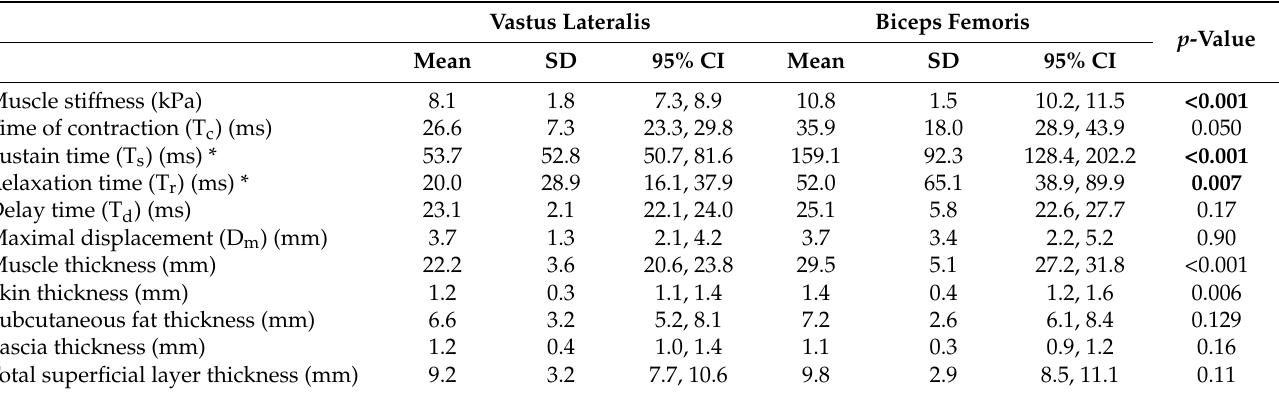
Table 1. Mean and 95% confidence interval for the ultrasound and tensiomyography variables for vastus lateralis and biceps